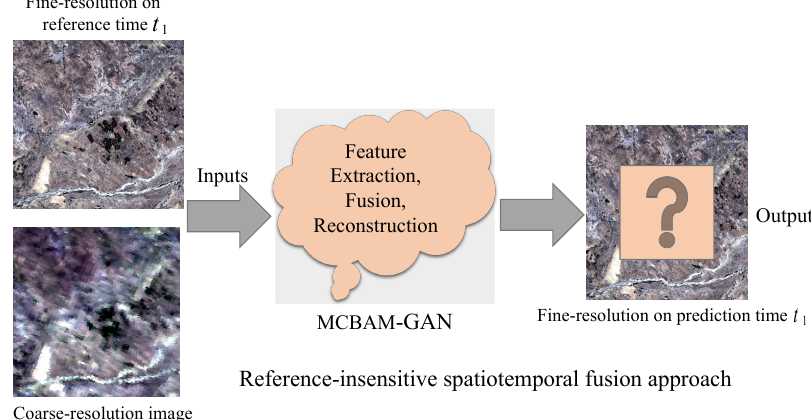
Figure 1. Objective Problems to be solved in the spatio-temporal fusion model based on deep learning (the model input uses only one coarse resolution image and another arbitrary fine resolution image at the prediction date as reference).